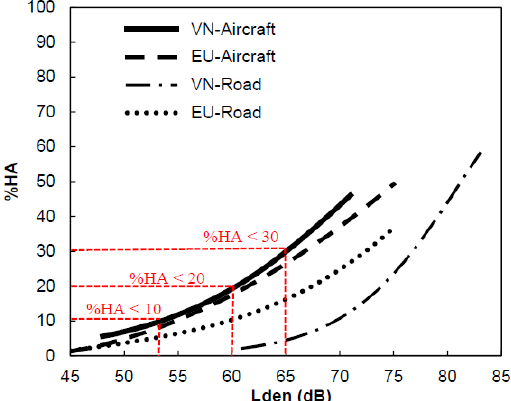
Figure 12. Exposure–response relationships for road traffic and aircraft noise, synthesized from the data of socio-acoustic surveys in Vietnam compared with those in the European Union position paper (L den –%HA relationships).